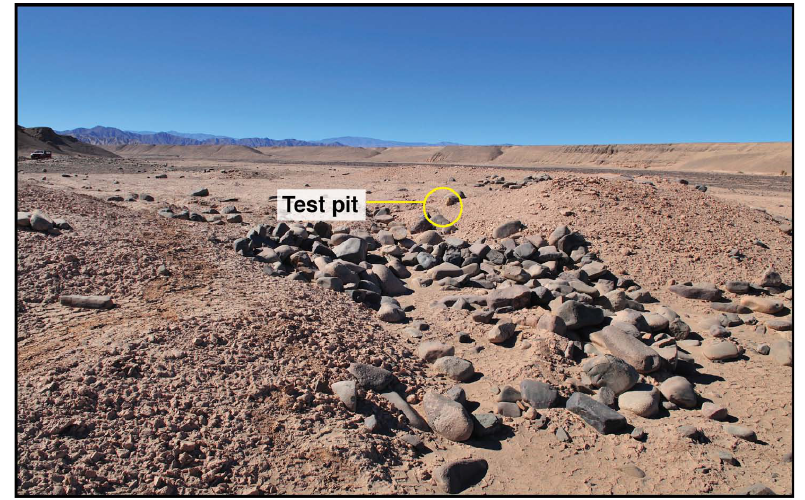
Fig. A6. Horseshoe-shaped dam extending over 18m on T2.5. Location for the test pit is